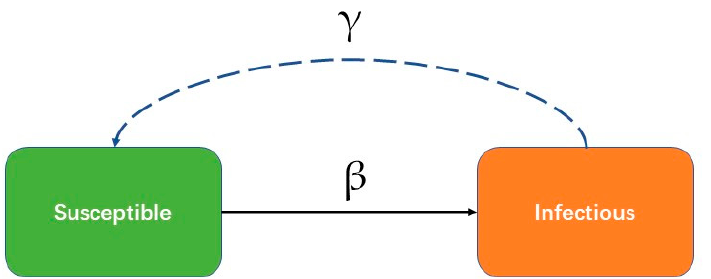
Figure 2. State transition diagram of the SIS propagation model, in which green and orange represent the susceptible and infected states respectively, and the arrows indicate the direction of the state transition.